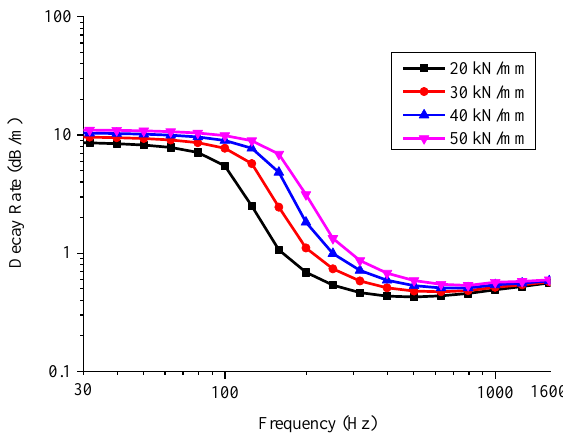
ff ness on the decay rate (DR).